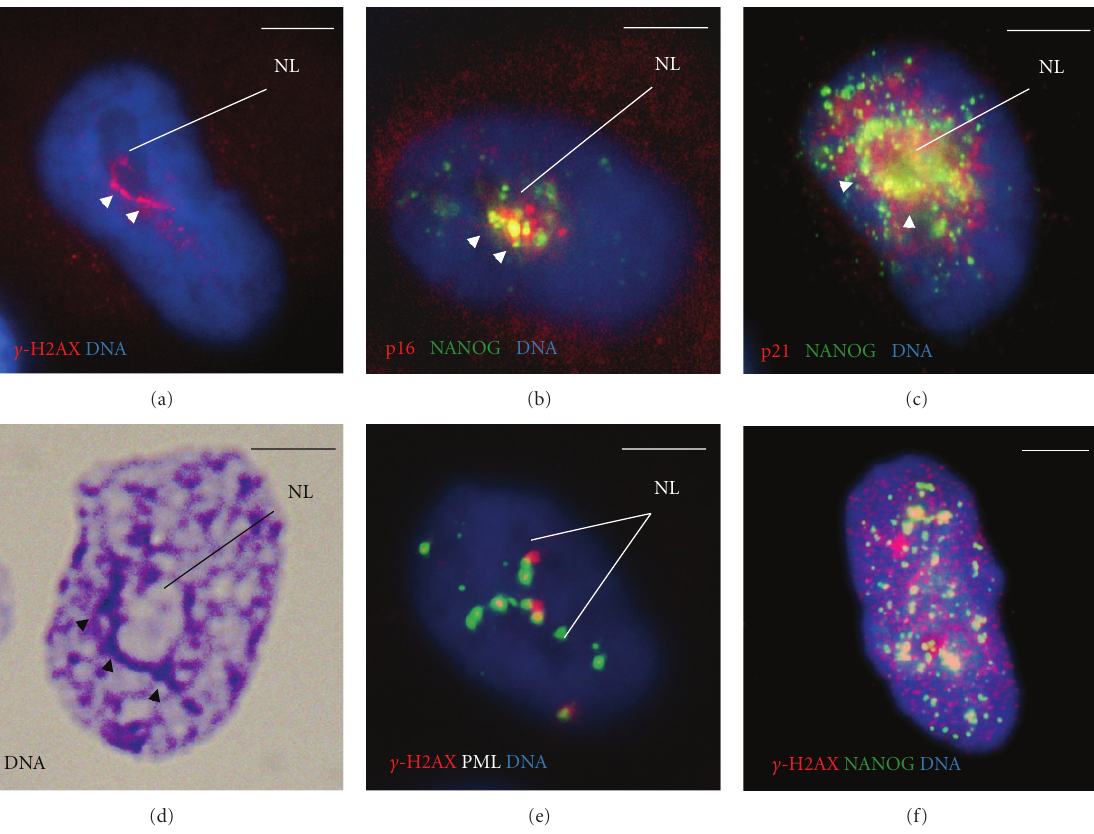
Figure 9: Characteristic cytological nuclear IF features of the tetraploid cells in the presenescence phase showing synergism of several labels located near the nucleoli. (a) Initial DDR in the perinucleolar chromatin indicated by the γ -H2AX-positive label (arrowheads), NL- nucleolus. (b) The accumulation of p16 and NANOG-positive, partly colocalising granules in the perinucleolar region (arrowheads). (c) The accumulation of p21 and NANOG—partial colocalisation around the central nucleolus (arrowheads). (d) The emergence of initial gentle SAHFs revealed by DNA-specific metachromatic staining with Toluidine-blue in the perinucleolar chromatin (arrowheads). (e) PML bodies in the vicinity of the central lobulated nucleolus, where they partly colocalise with γ -H2AX-foci. (f) The tetraploid cell from the mid- presenescence with the network of γ -H2AX and some amount of NANOG, partially colocalised. Images were obtained using BRG three- colour optical filters system. Scale bars = 10 μ